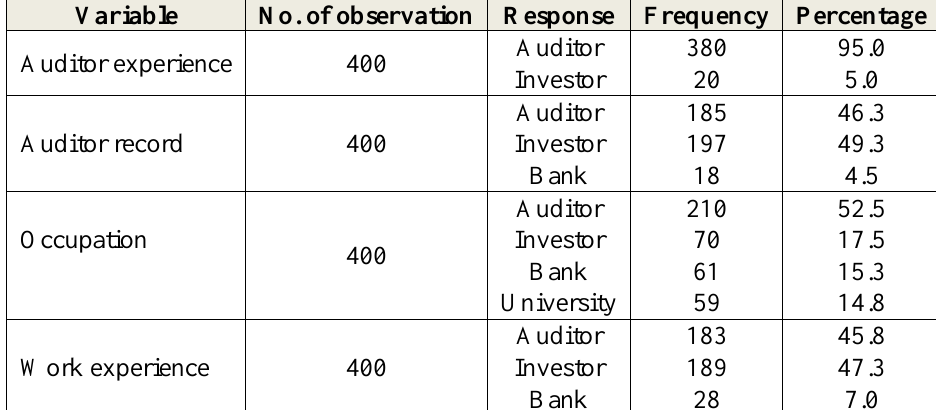
Table 1. Results of frequency analysis of qualitative data